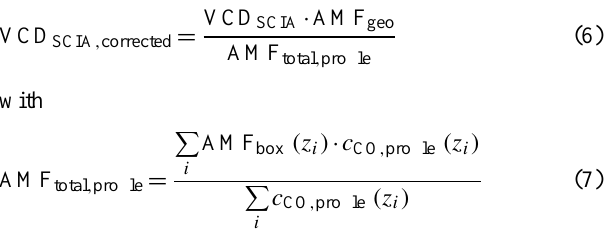
Fig. 4. Standard CO profile assumed for the calculation of the SCIAMACHY total CO column density standard data set.